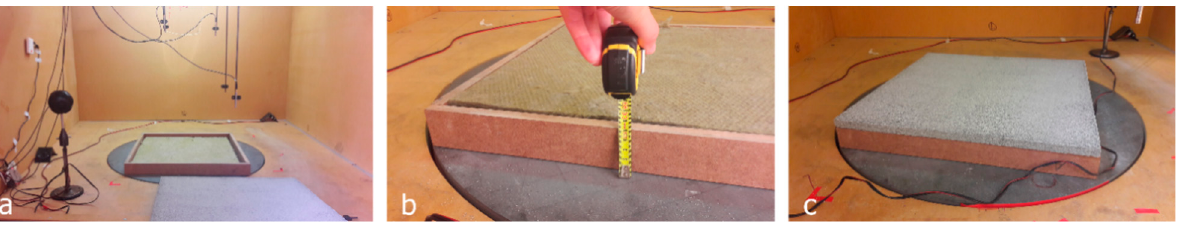
Figure 3. Mounting on 50 mm air gap. Sample ( A ): crushed normal weight aggregates 4–8 mm; Sample ( B ): round lightweight aggregates 4–8 mm; Sample ( C ): round lightweight aggregates 2–4 mm; Sample ( D ): round lightweight aggregates 0.5–1 mm.